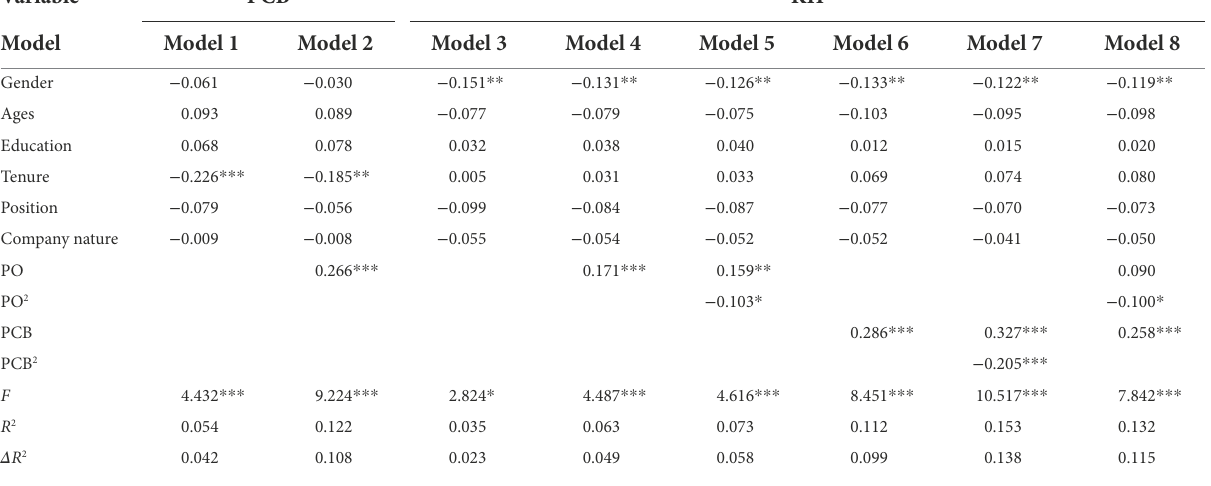
TABLE 6 Mediating effect of psychological contract breach ( N = 475).